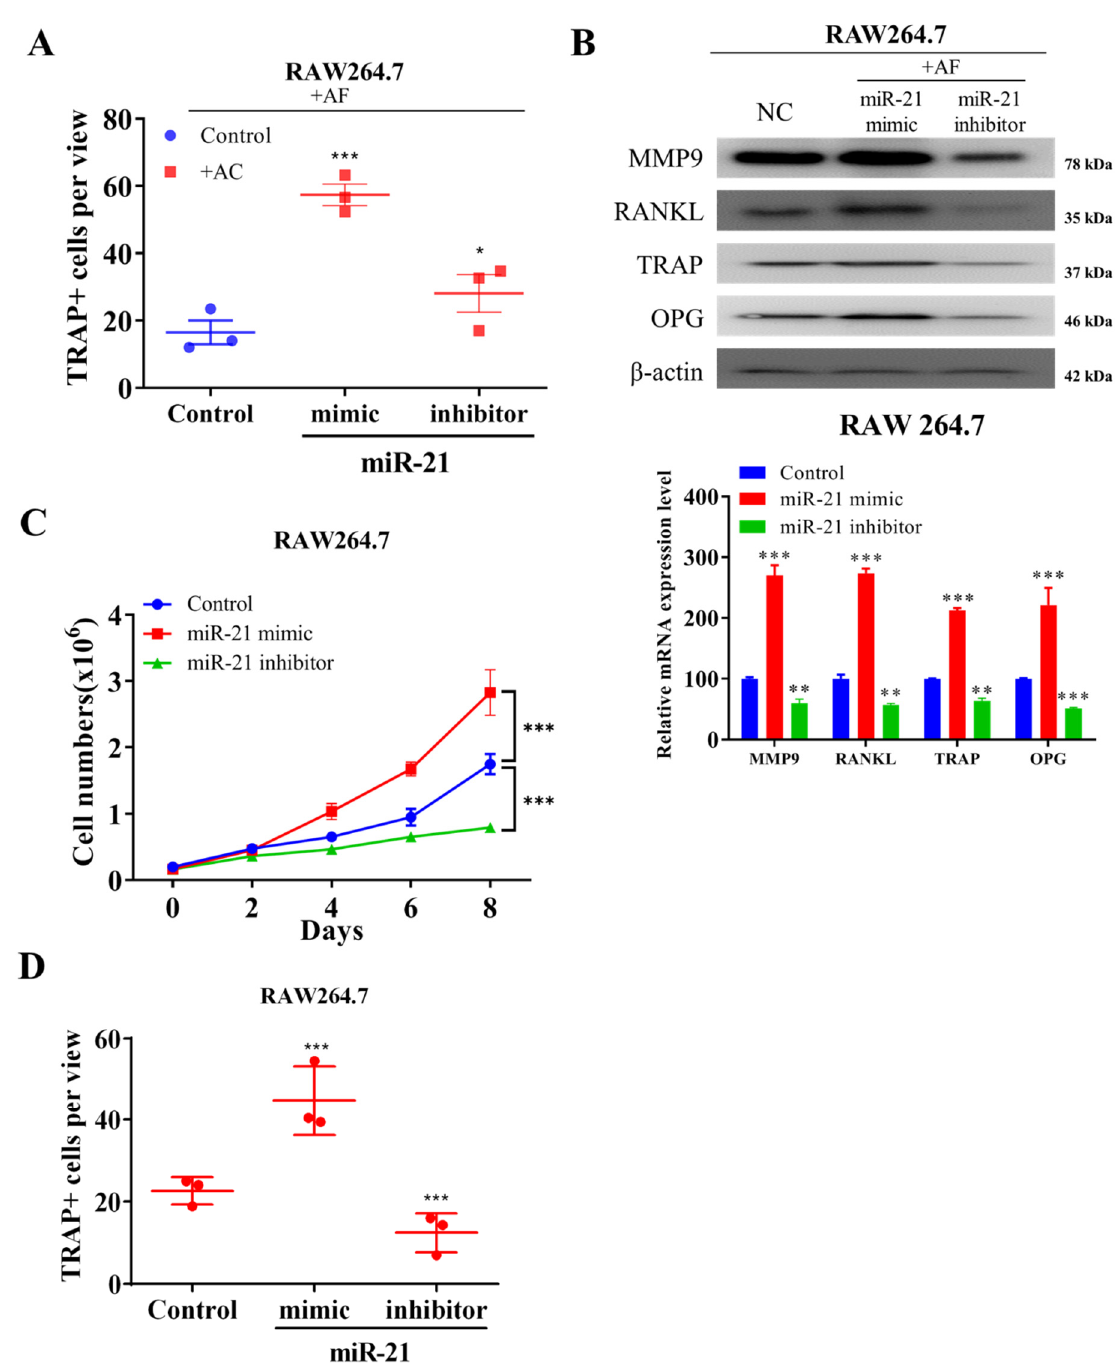
Figure 3. Overexpression of miR-21 in-vitro promotes the differentiation of osteoclasts. ( A ) Quantification of multinucleated TRAP+ RAW264.7 cells cocultured with miR-21-overexpressing and inhibited SW982 (AF) cells. ( B ) Western and bar plot demonstrated the expression of the level of osteoclast-specific genes in SW982 (AF) co-cultured RAW264.7 cells. ( C ) Effect of miR-21 overexpression and inhibition on the cell proliferative effect and the osteoclast differentiation of SW982 (AF) co-cultured RAW264.7 cells. ( D ) The osteoclast differentiation condition in presence of RANKL/M-CSF on miR-21-inhibited RAW264.7 cells. * p < 0.05, ** p < 0.01 and *** p < 0.001. 2.4. Inhibition of NF- κβ Dampens Cellular Transformation of Activated Fibroblasts, Chondrocytes, and Osteoclasts NF κ B is a principal factor in chronic inflammation and progression of osteoarthritis [36,37]. In addition, miR-21 has been shown to induce NF κ B activity and promote NF κ B